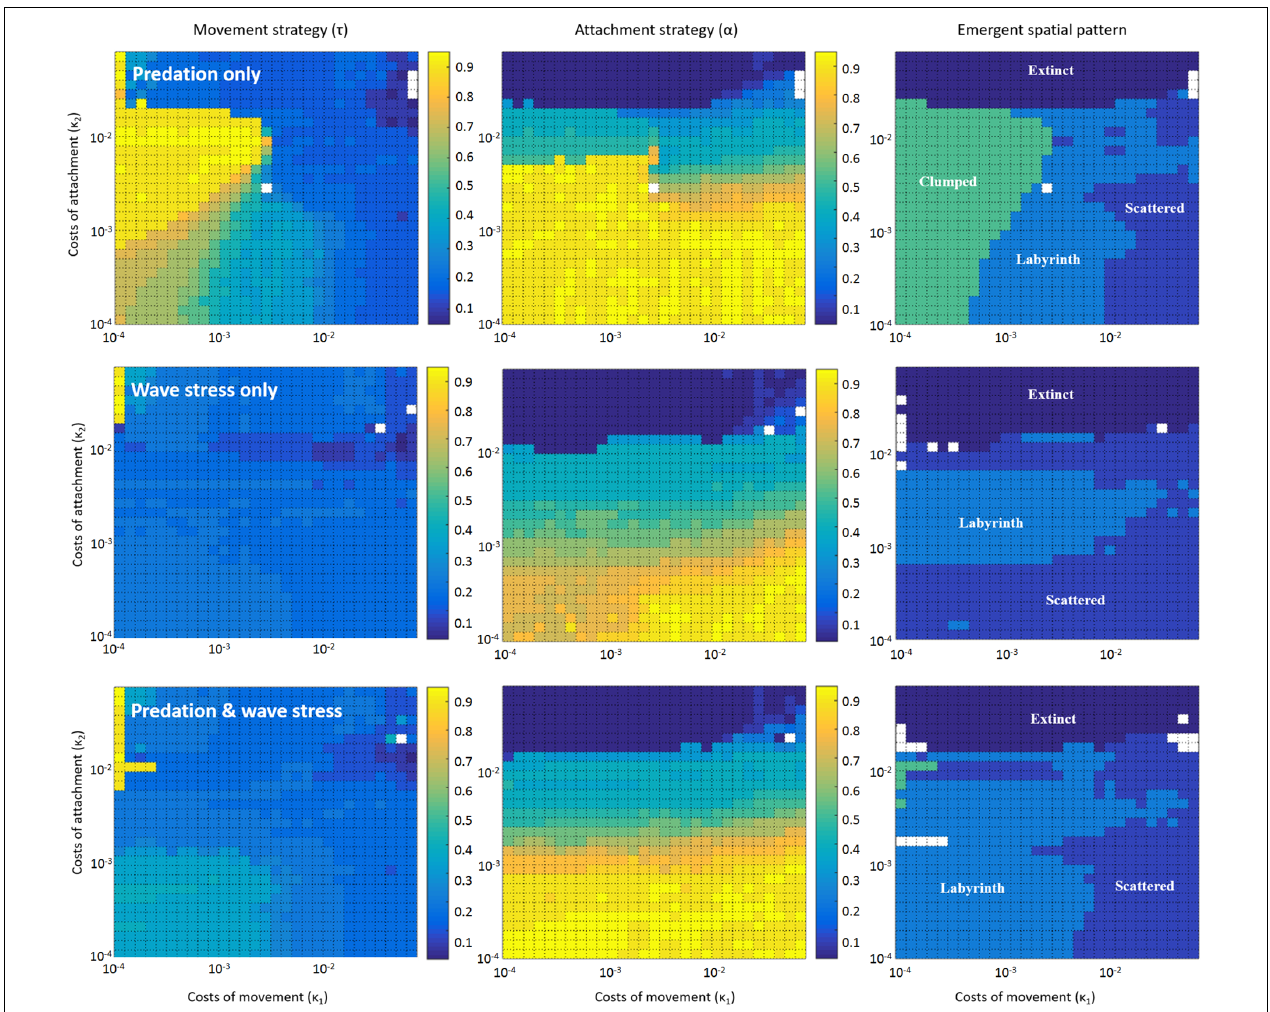
FIGURE 4 | Dependence of evolved spatial patterns on the cost parameters in case of predation only ( Top ; n 50 = 20); wave stress only ( Middle ; g 50 = 200); and the joint action of predation and wave stress ( Bottom ; n 50 = 20 and g 50 = 200). Left , Middle , and Right panels show the evolved movement strategy ( τ ), the evolved attachment strategy ( α ), and the emergent spatial pattern, respectively, for different combinations of movement cost ( κ 1 ) and attachment cost ( κ 2 ).